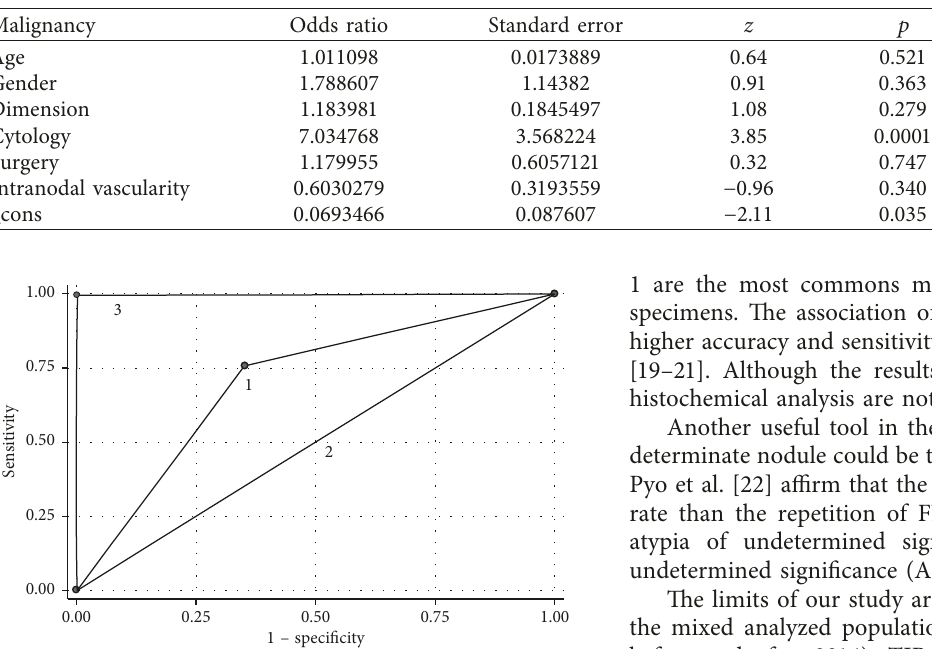
Table 6: Multivariate logistic regression